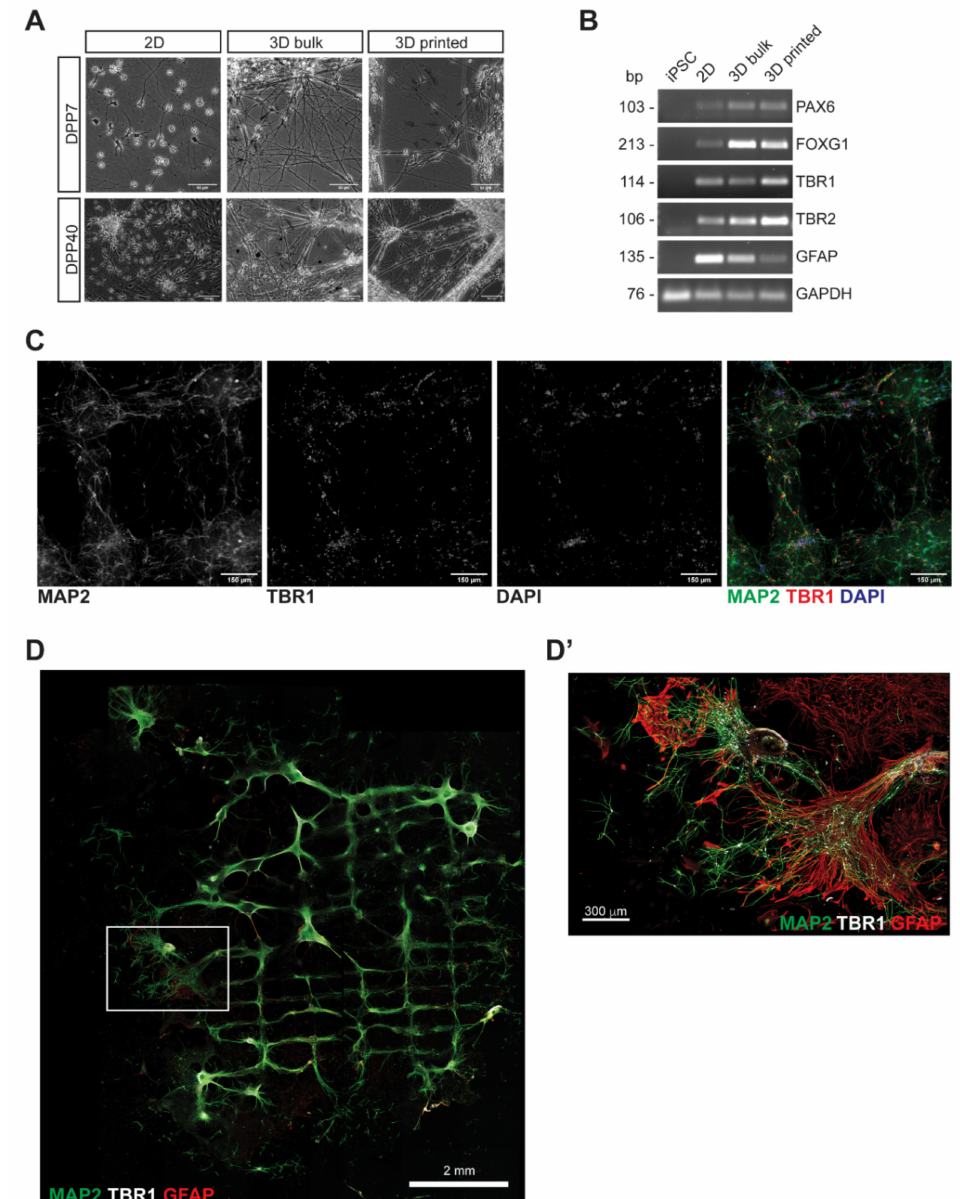
Figure 2. Analysis of neural marker expression in the 3D bioprinted construct. ( A ) Phase contrast images of cells within the 3D bioprinted construct (“3D printed” panels), at the indicated days post printing, and cells in conventional monolayer conditions (“2D” panels) or resuspended in the bioink (“3D bulk” panels) and maintained for the same time of di ff erentiation. ( B ) RT-PCR analysis of neuronal progenitor markers ( PAX6 , FOXG1 , TBR2 ), a cortical neuron marker ( TBR1 ) and an astrocyte marker ( GFAP ). GAPDH was used as a housekeeping control. ( C ) Immunostaining analysis of bioprinted cells at DPP7. MAP2 (green), TBR1 (red) and DAPI (blue) signals are shown. Scalebar: 150 µ m. ( D ) Mosaic reconstruction of confocal images of bioprinted neural cells at DPP70, showing the entire sample, stained with MAP2 (green), TBR1 (white) and GFAP (red) antibodies. Scalebar: 2 mm. ( D’ ) Mosaic reconstruction of confocal images of the region inside the white box in panel D, acquired at higher resolution. Scalebar: 300 µ